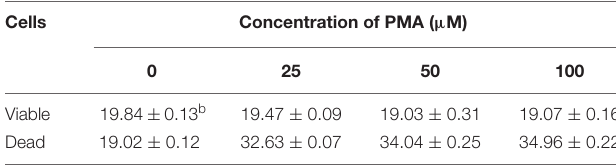
TABLE 1 | Effect of different concentrations of PMA on signal suppression of dead cells of E. coli O157:H7 in PMA-qPCR a